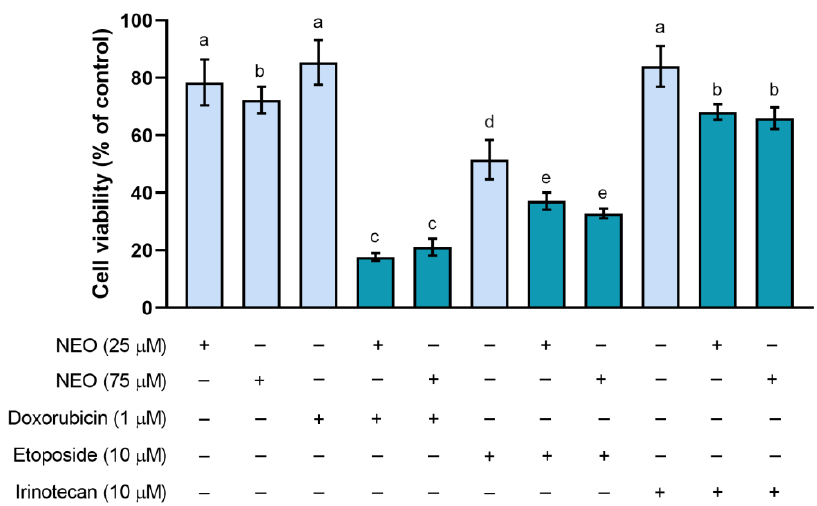
Figure 2. SW1783 cells viability comparison among groups treated for 48 h with only NEO (25 μM and 75 μM), a drug alone: doxorubicin (1 μM), etoposide (10 μM,) and irinotecan (10 μM), and NEO–drug mixtures (bars indicated in a darker color). Mean values ± SD from three independent experiments are presented. Means not sharing a common superscript differ significantly at p < 0.05.